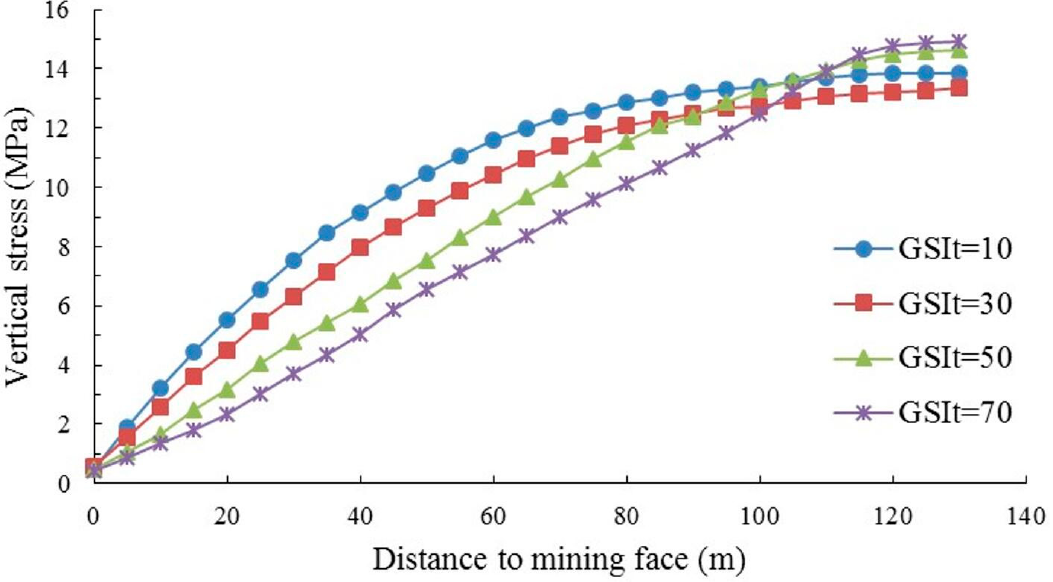
Figure 8. Stress data along the panel centerline in the goaf with respect to different GSI t values.